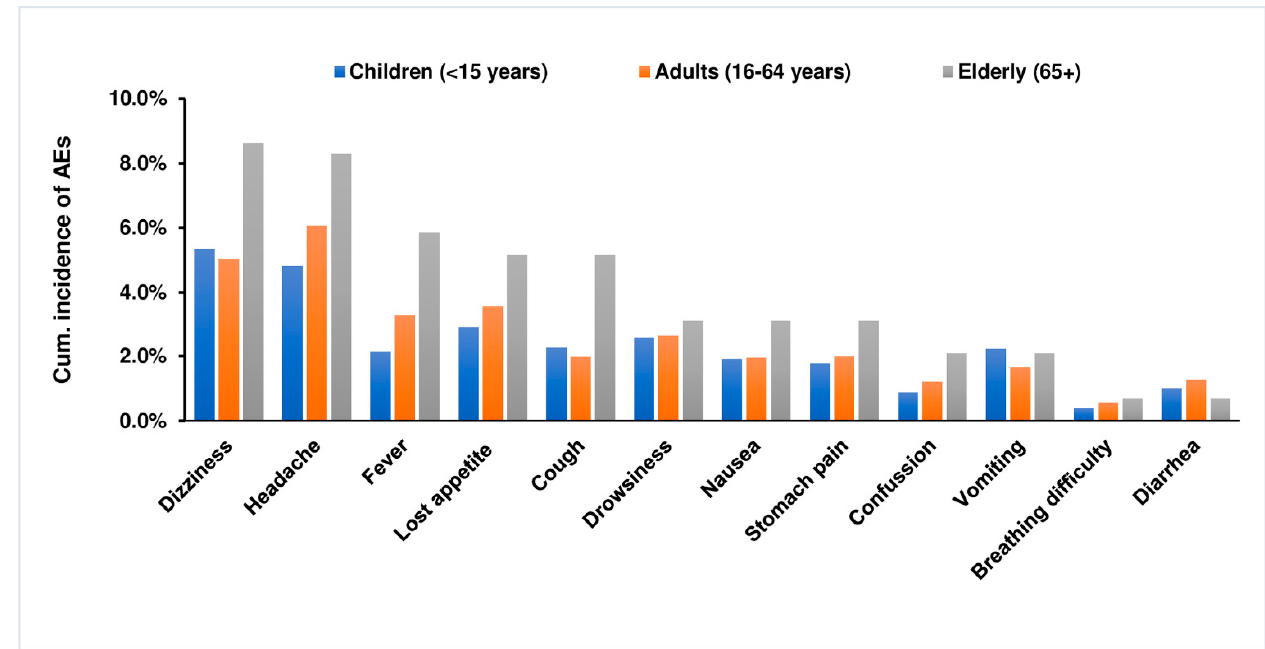
Figure 3. Cumulative incidence of adverse events (AEs) reported over 7 days following mass diethylcarbamazine plus albendazole administration among the different age groups.